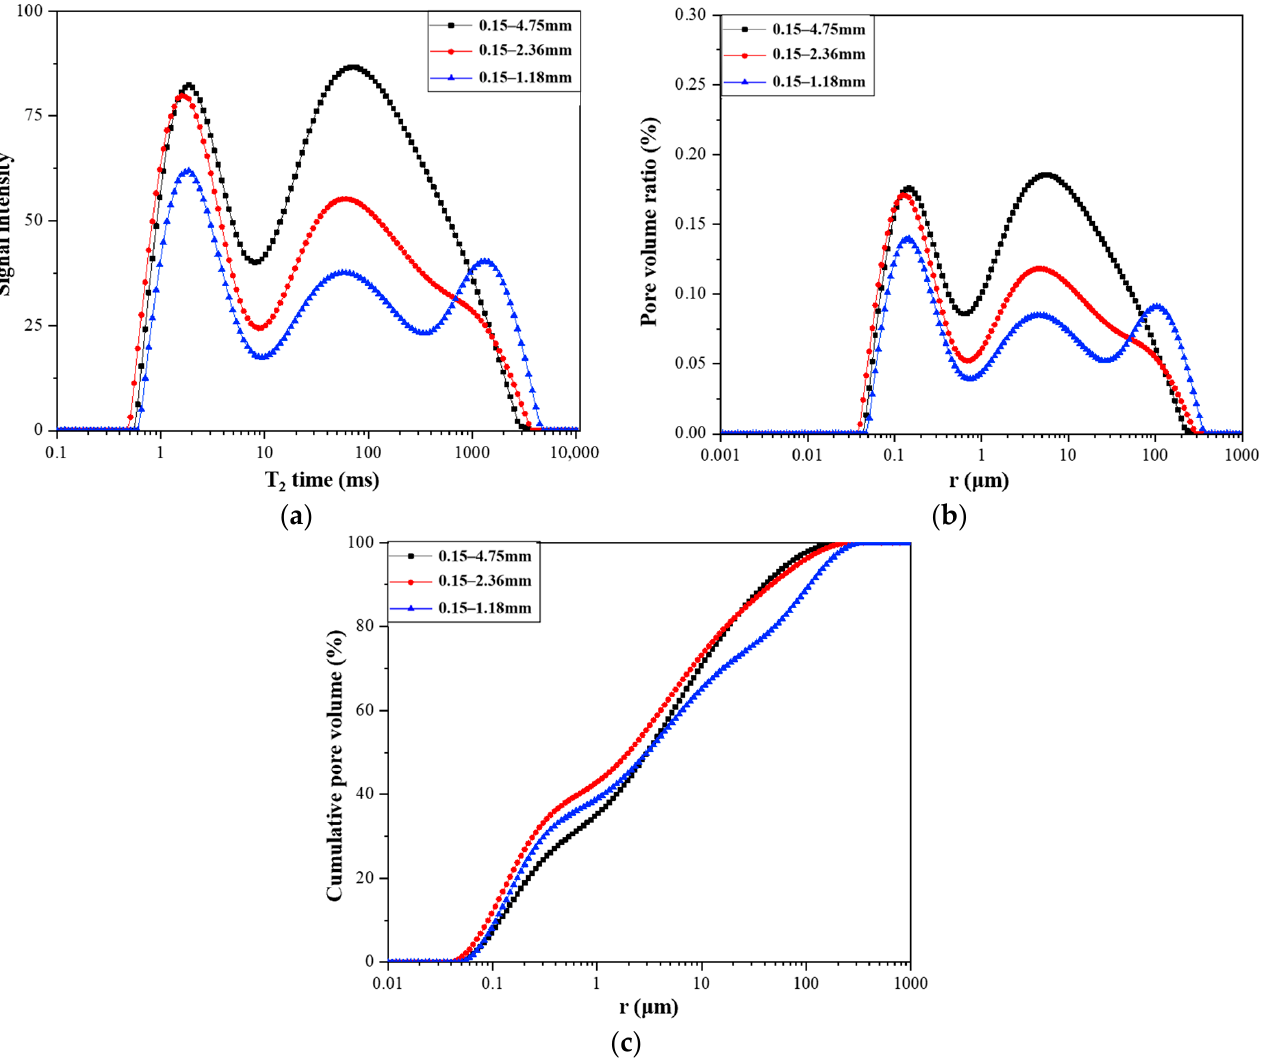
Figure 9. Effect of LWA particle size on the pore structure of L-UHPC. ( a ) Effect of LWA particle size on the T 2 spectra of L-UHPC; ( b ) effect of LWA particle size on the pore size distribution of L-UHPC; ( c ) effect of LWA particle size on the cumulative pore size distribution of L-UHPC.